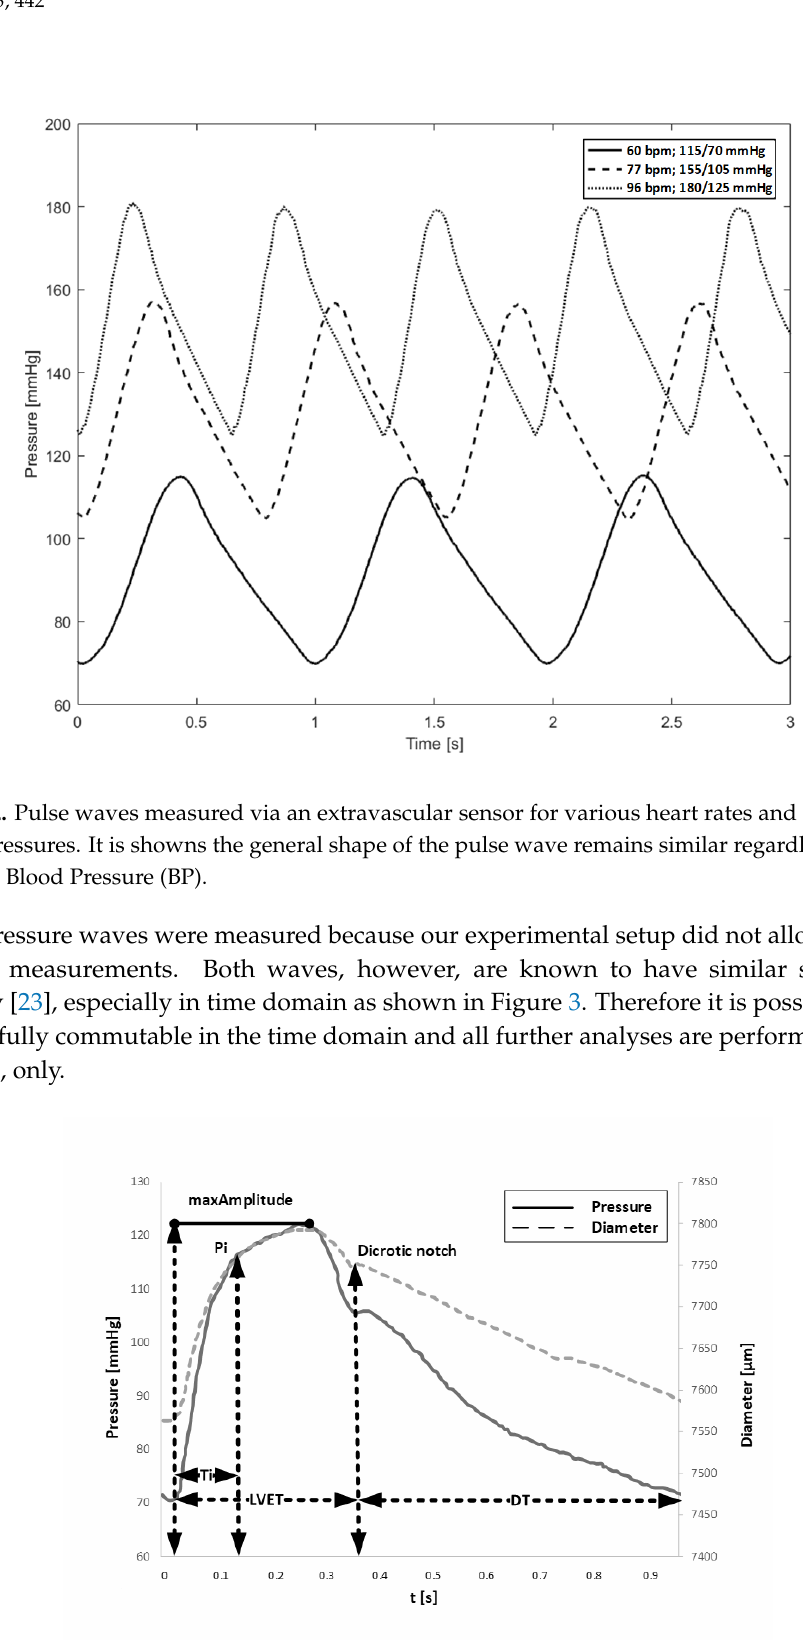
Figure 3. Comparison of aortic diameter and pressure pulse waves during one cardiac cycle (data from [23], page 162) shows similar shapes of both waves with qualitatively the same features in time domain (left ventricular ejection time (LVET), diastolic time (DT), travel time of the reflected wave (Ti)) were